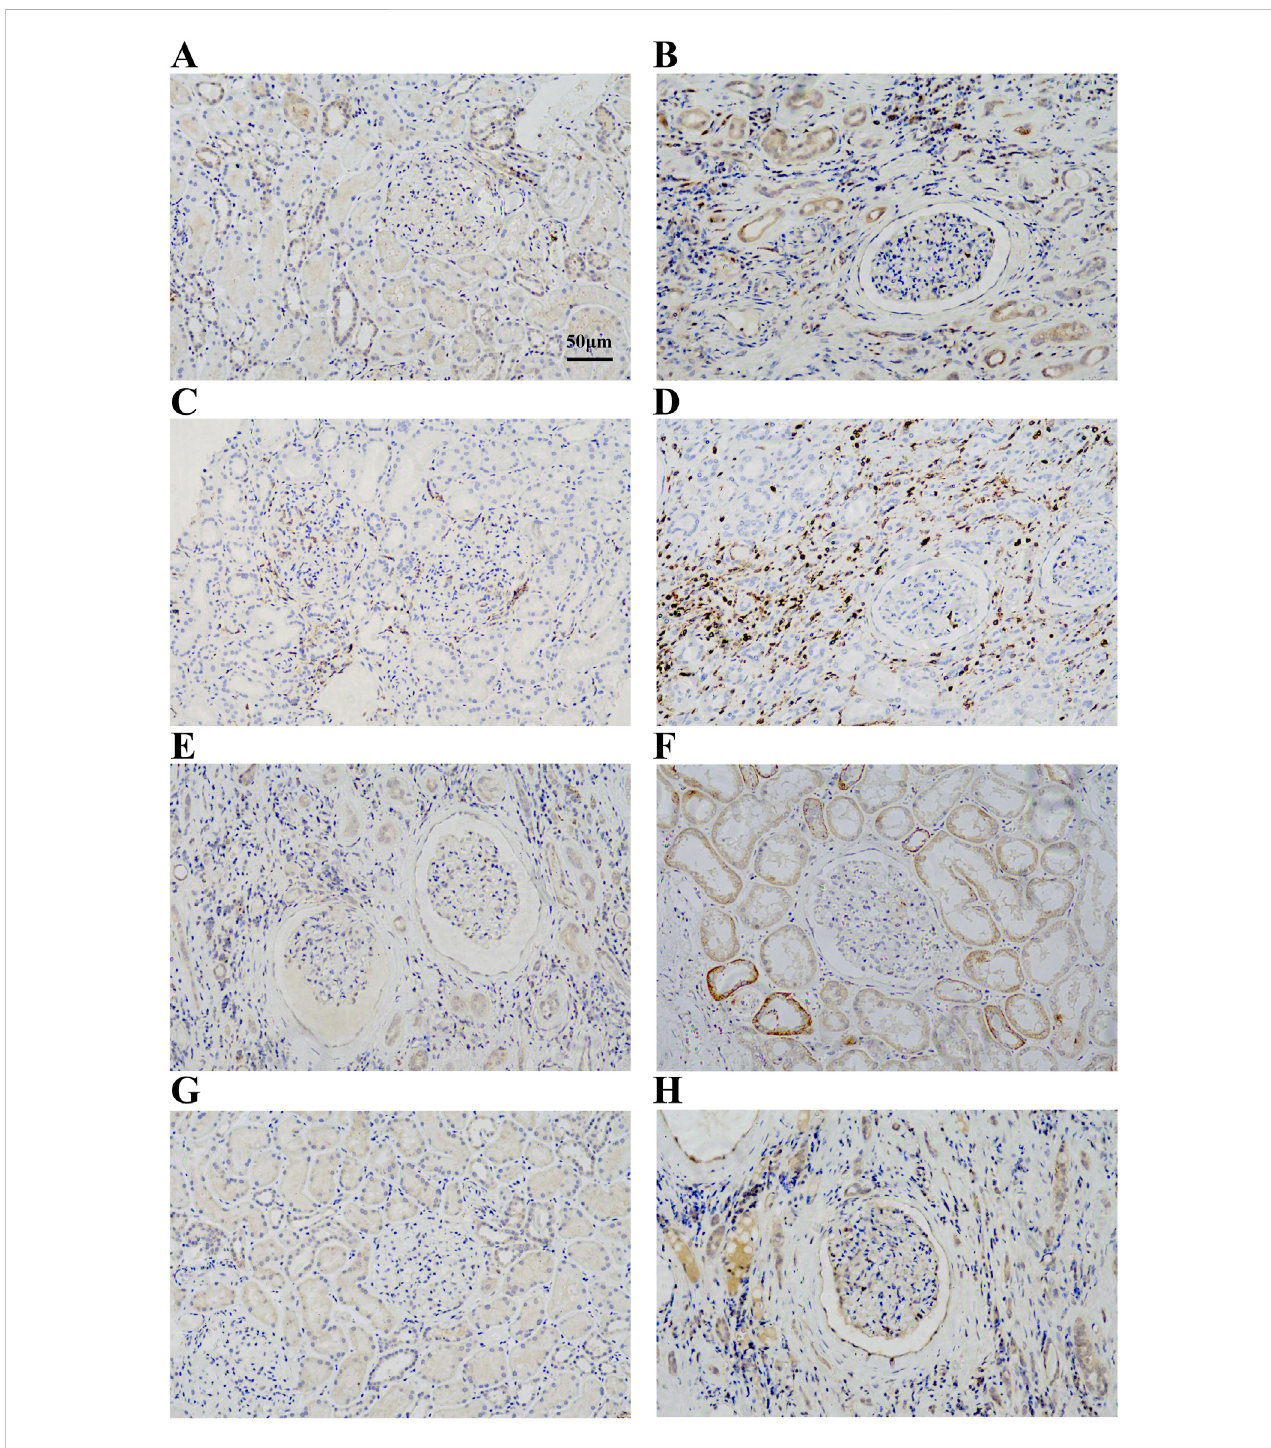
FIGURE 7 (A) Immunohistochemical analysis of IL10RA expression in control group. (B) Immunohistochemical analysis of IL10RA expression in CKD group. (C) Immunohistochemical analysis of CD45 expression in control group. (D) Immunohistochemical analysis of CD45 expression in CKD group. (E) Immunohistochemical analysis of CTSS expression in control group. (F) Immunohistochemical analysis of CTSS expression in CKD group. (G) Immunohistochemical analysis of C1QA expression in control group. (H) Immunohistochemical analysis of C1QA expression in CKD